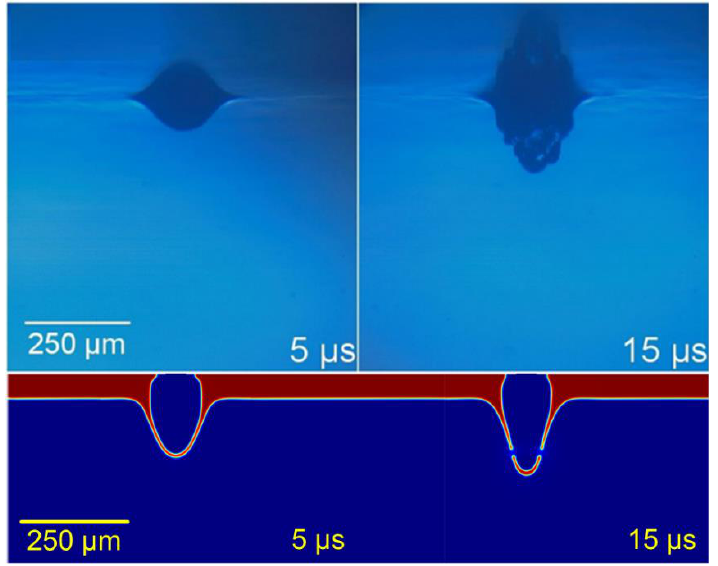
Figure 6. Cluster transference regime. Upper row adapted from [13], with PV17F paste. Lower row: simulation at 400 MPa at its maximum, for 60 µ m of 2 Pa · s paste.